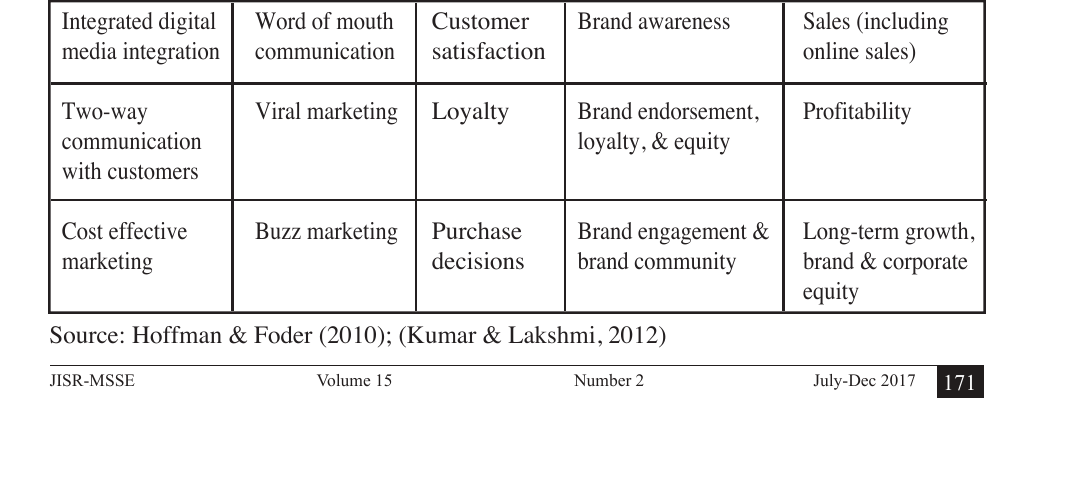
Source: Hoffman & Foder (2010); (Kumar &